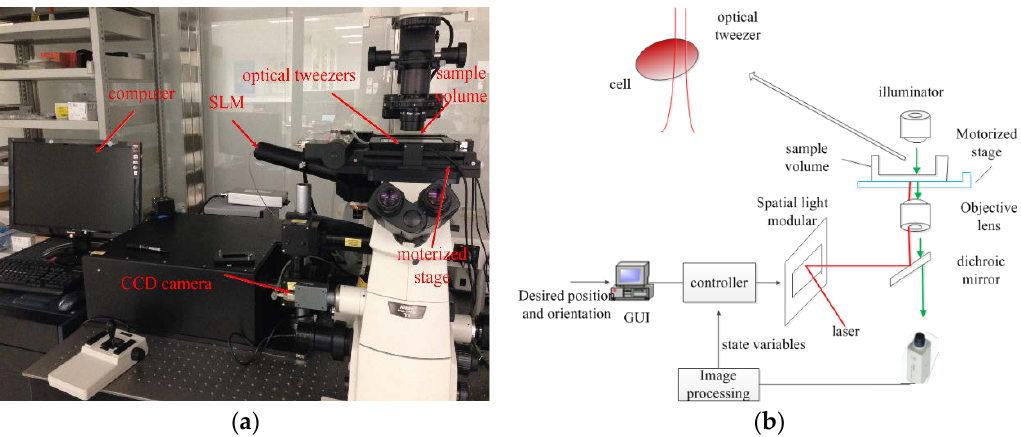
Figure 1. Robot-aided holographic optical tweezers cell manipulation system. ( a ) Experimental setup; and ( b ) illustration of the light path